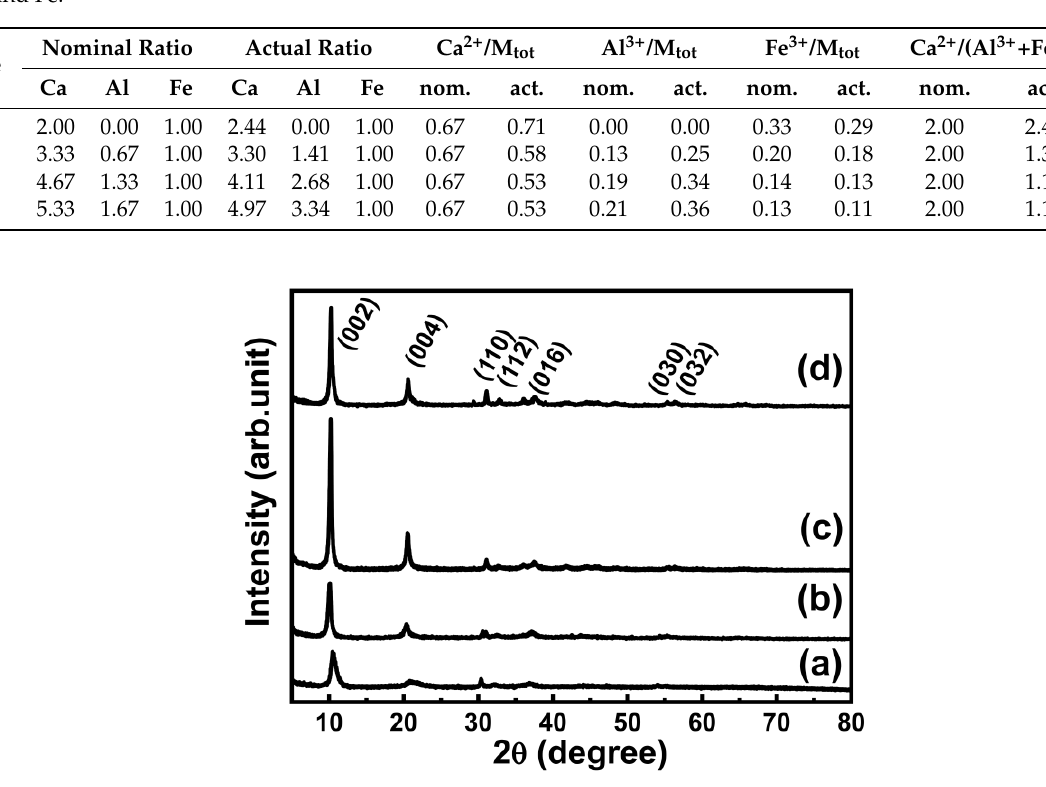
Figure 2. XRD patterns of Ca–Al–Fe LDHs with various Ca/Al/Fe ratios ( a ) CAF1, ( b ) CAF2, (c) CAF3, and ( d ) CAF4.